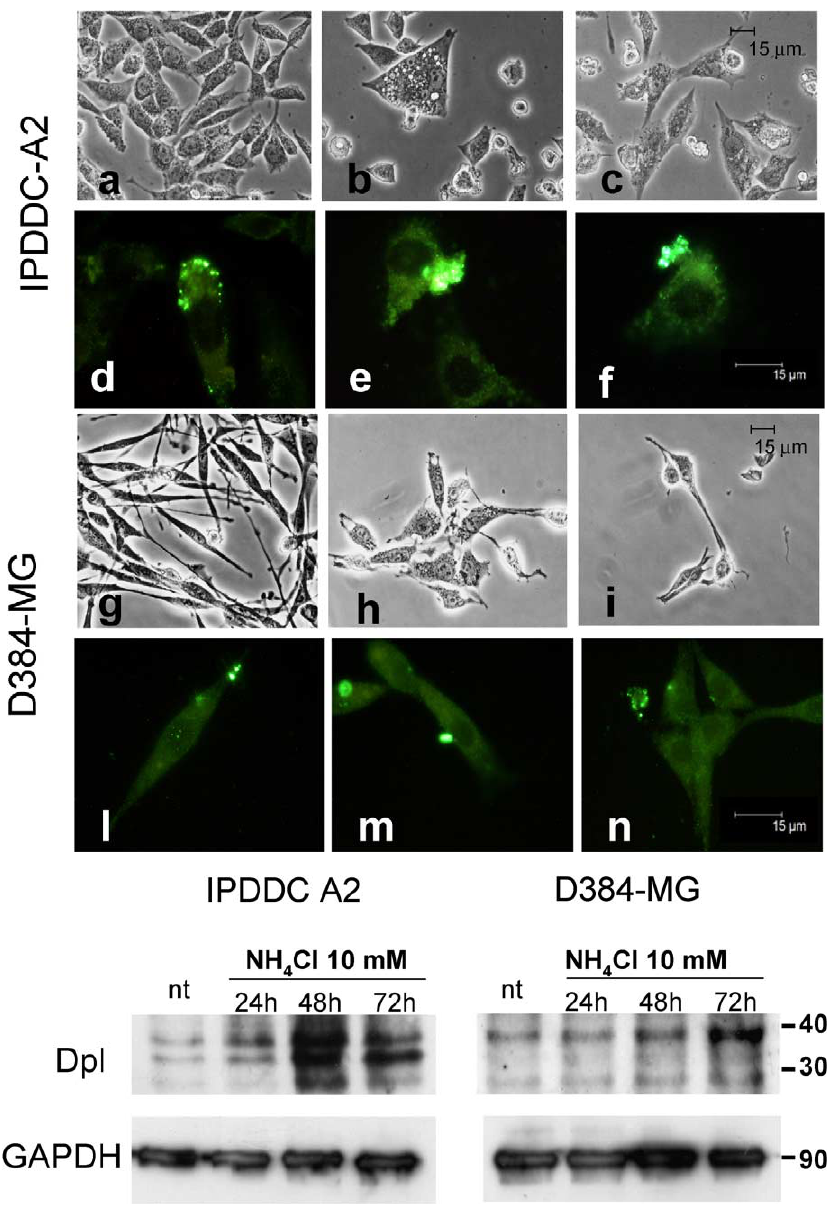
Fig. 5. Effect of ammonium chloride treatment on the Dpl traffic and expression in IPDDC-A2 and D384-MG cells. IPDDC-A2 cells were treated with 10 mM ammonium chloride, analysed in their morphology and in Dpl immunofluorescence after 24, 48 and 72 h, and finally compared to untreated control cells (a); extensive vacuolization was observed at 48 h (b) and several budding vesicles after 72 h (c). Dpl immunolocalization showed strong signals after 48 h in correspondence of the inner layer of the plasma membrane (d); Dpl was significantly accumulated in nascent budding and exocytic vesicles at 72 h (e and f). In D384-MG cells, treated as above, changes in morphology compared to the controls (g) were observed after 48 h (h), while several rounded and shrunken cells appeared after 72 h (i). Dpl immunolocalization showed strong signals after 48 hours in correspondence of the apical portion of the cells (l); as above described, Dpl was significantly accumulated in nascent budding and exocytic vesicles at 72 h (m and n). The morphology of the cells and Dpl immunofluorescence reactivity were DIC visualised with an inverted fluorescence microscope (Eclipse TS100, Nikon, original magnifications, 10, 40 and 100 × ). The scale bars are reported. Dpl expression in IPDDC-A2 and D384-MG cells was analysed by immunoblotting using the D7C7 anti-Dpl monoclonal antibody. Controls (NT) were compared to ammonium chloride treated cells after 24, 48 and 72 h. Control GAPDH protein expression was reported. Molecular weights (kDa) are